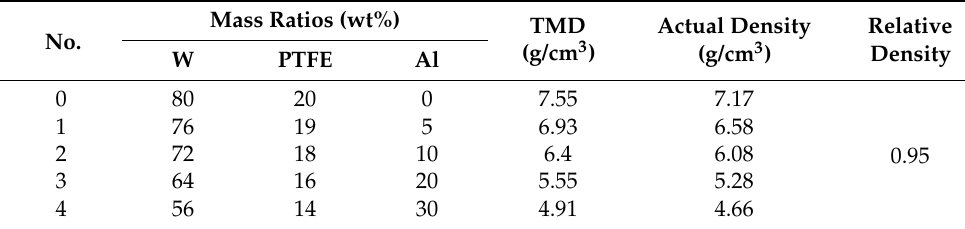
( b ) Figure 3. Measurement of ignition temperature: ( a ) reactor, ( b ) photo of the assembly in the reactor: (1) boron nitride crucible, (2) graphite heater, (3) specimen, (4) current conductors, (5) thermocouple. The shock-wave initiation ability of the compounds was determined through 1 km/s oblique impact of a steel plate (100 mm in diameter and 2.5 mm in thickness) at a matrix (100 mm in diameter and 20 mm in thickness, Figure 4a) with the specimens (Figure 4b). The cylindrical specimens with a diameter of 10 mm, a height of 10 mm, and a relative density of 0.98 were used. The same loading conditions for all specimens were provided by the initiation of the explosive detonation from the center of the assembly. The phase composition of the products was characterized by X-ray diffraction (XRD, DRON-3M, Burevestnik, St. Petersburg, Russia). The specimens were scanned from 20° to 80° (2 Θ ) with a scanning step of 0.02°.